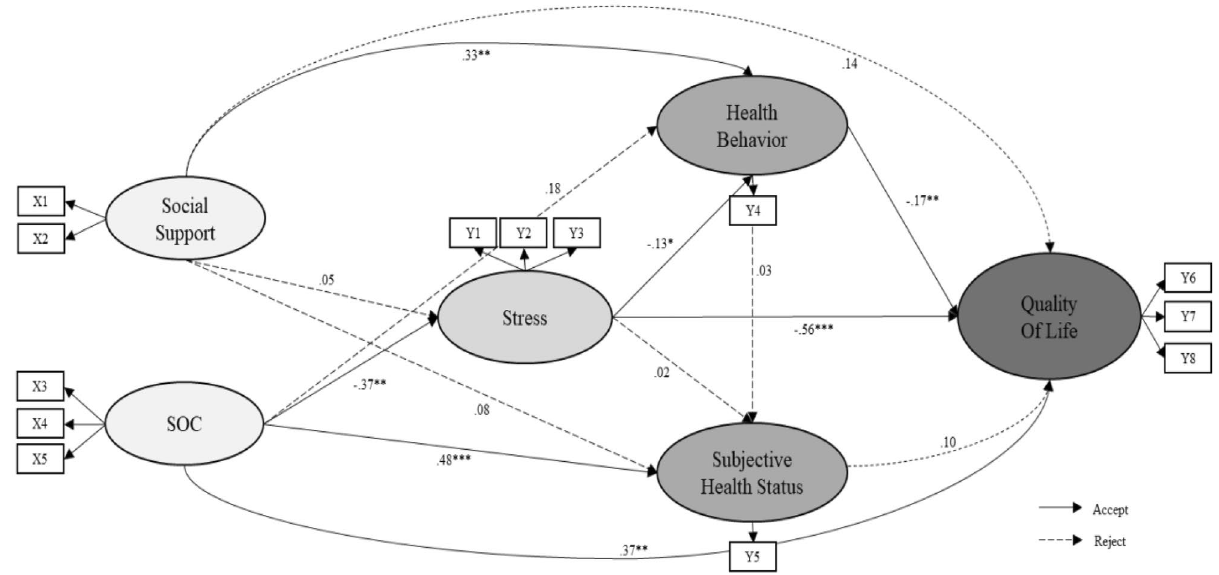
Figure 2. Path diagram for the hypothetical structural equation